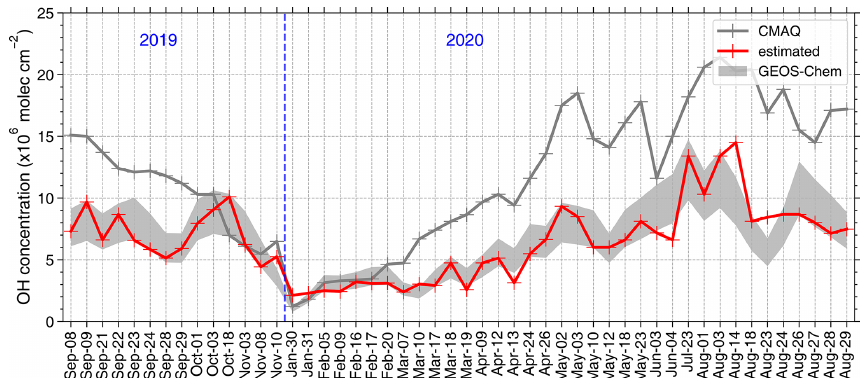
Figure 2. Daily boundary layer mean OH concentration over our study domain. The OH concentration estimated from our improved super- position column model is given with the red line. The grey shade represents 0.8–1.2 times the GEOS-Chem-simulated OH concentration, and the grey line represents CMAQ model simulation